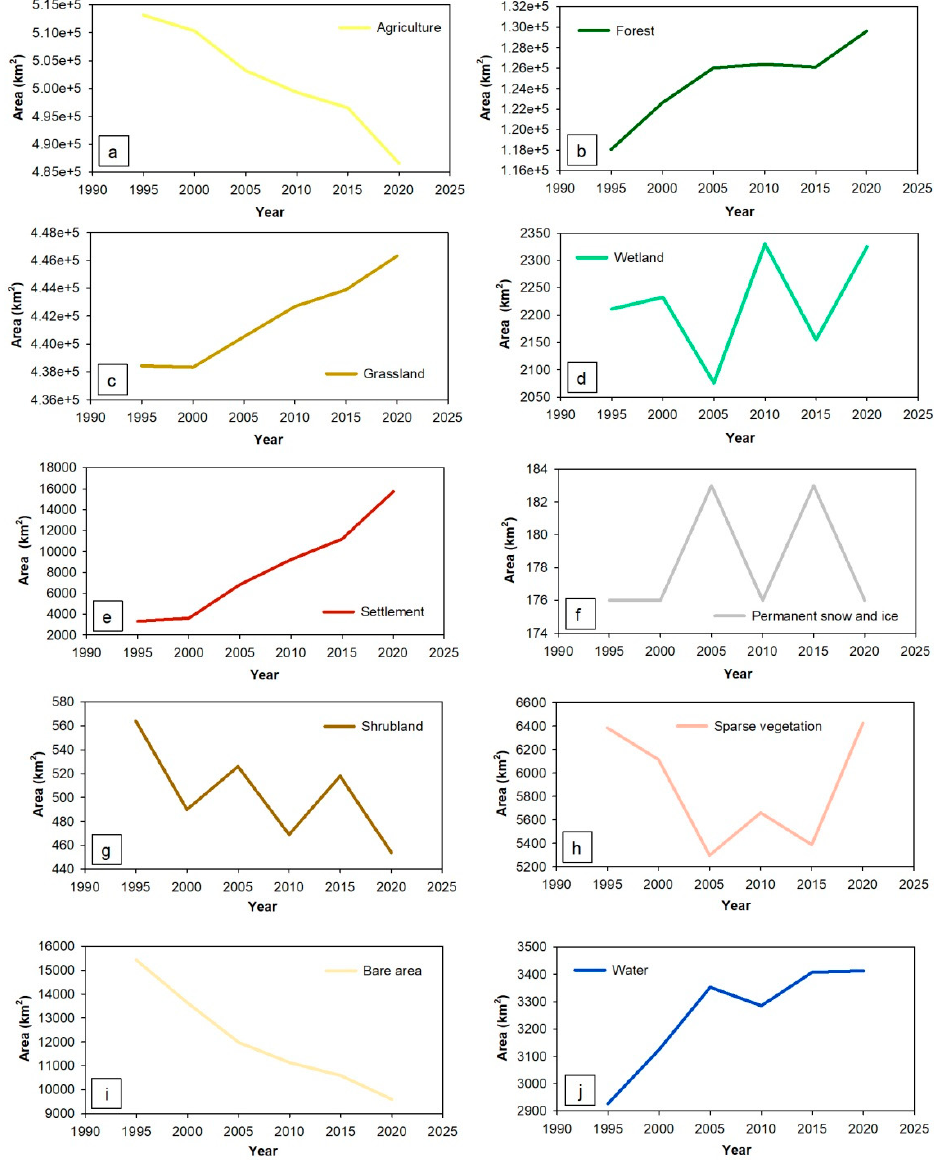
Figure 12. Land cover in mountainous areas of the GYRR in different years. We tried to use colors similar to the colors of different land cover types.